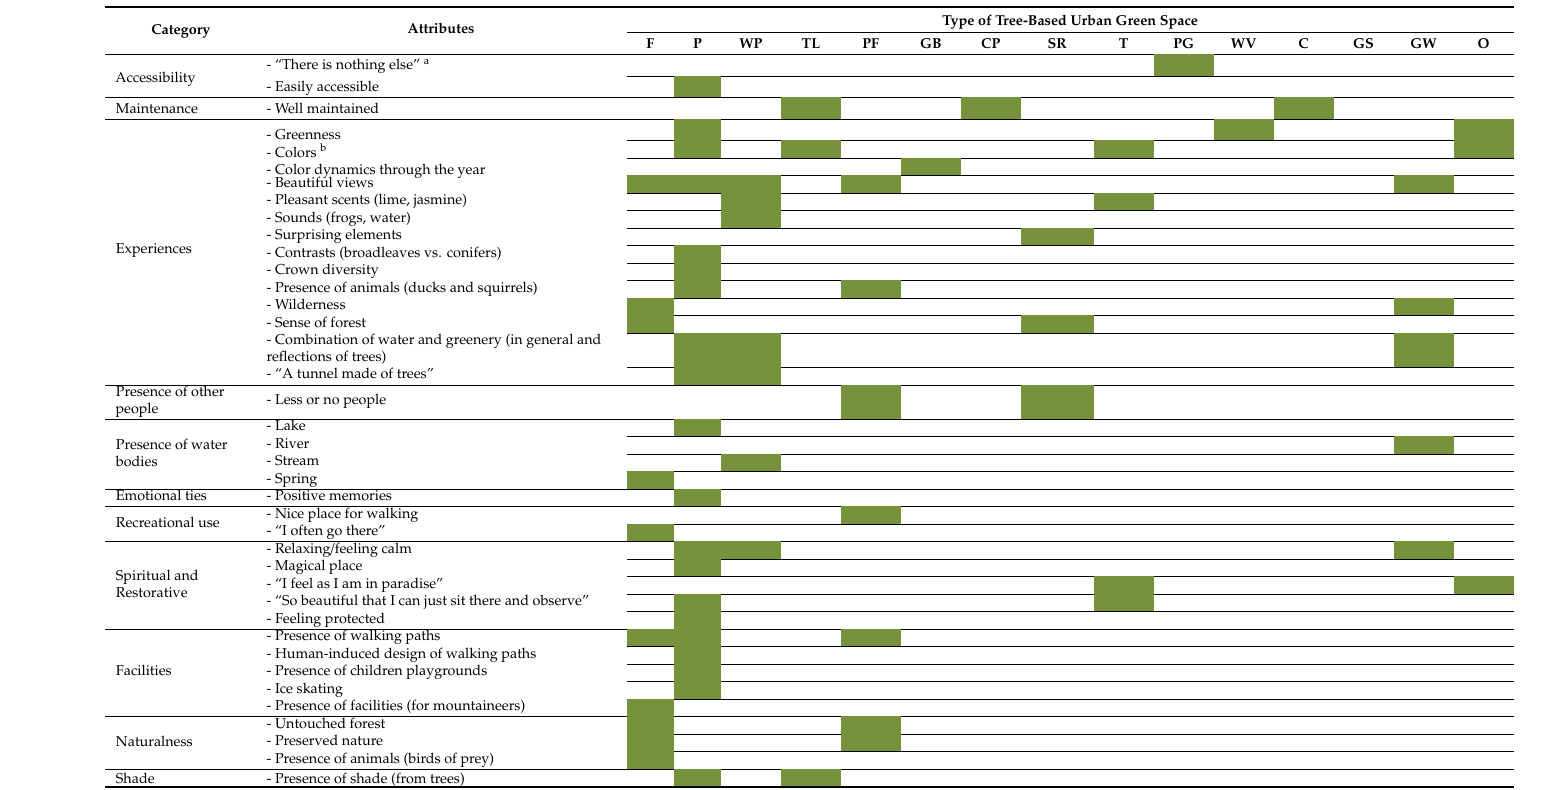
Table 4. Categories and attributes with regard to aesthetically appealing tree-based urban green space (UGS). Green indicates the assignation of an attribute to particular type of UGS (F—forest, P—park, WP—walking paths along the streams, TL—tree lines, PF—park forest, GB—greenery around residential buildings, CP—children playgrounds, SR—greenery of sports and recreational facilities, T—trees, PG—private garden, WV—window view, C—cemeteries, GS—green system, GW—greenway, O—other). Quotations refer to verbatim statements of the